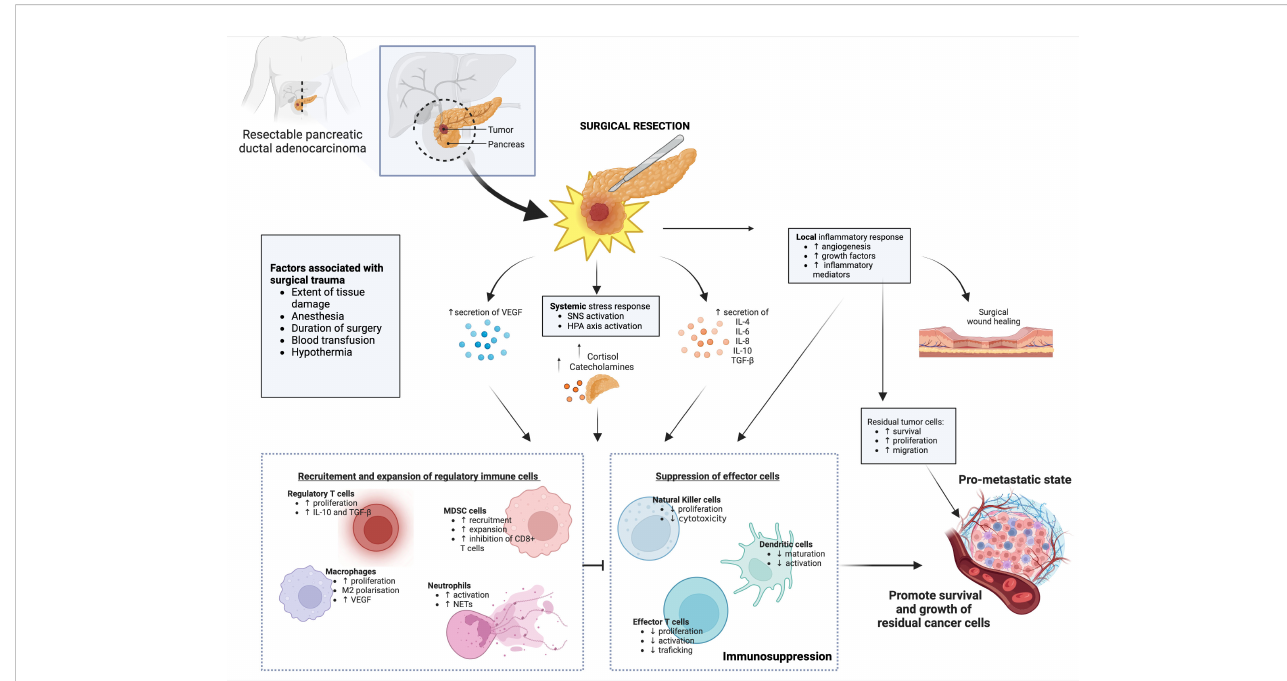
FIGURE 2 Schematic representation of the mechanisms of postoperative immunosuppression. Surgical resection of pancreatic cancers initiates local and systemic in fl ammatory and stress responses, which leads to dysregulated cytokine, growth factors and stress hormone secretion levels. While necessary for tissue and cellular repair following surgical excision, these in fl ammatory responses result in expansion and recruitment of regulatory immune cells, which in turn impair tumor-targeted effector immune cells. When combined with other negative factors associated with surgical trauma, such as duration of anesthesia, blood loss and hypothermia - a pro-metastatic state establishes in the patient, which promotes growth and migration and residual cancer cells. Abbreviations: SNS, Sympathetic nervous system; HPA, hypothalamic-pituitary-adrenal; VEGF, vascular endothelial growth factor; TGF- b , Transforming growth factor beta; MDSC, myeloid derived suppressor cells; NET, neutrophil extracellular traps; IL, interleukins. Created with